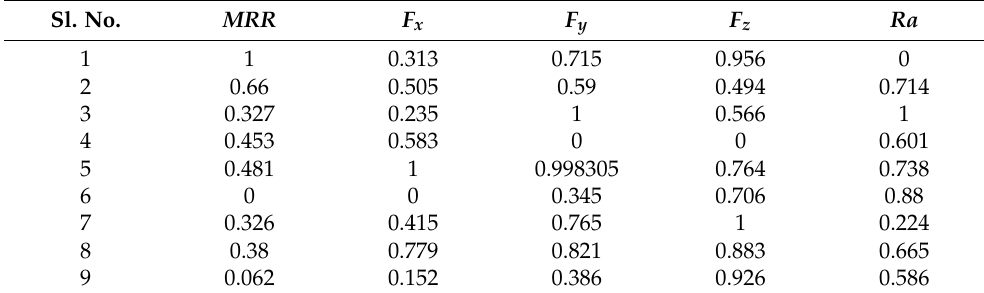
Table 8. Scaled ratio of